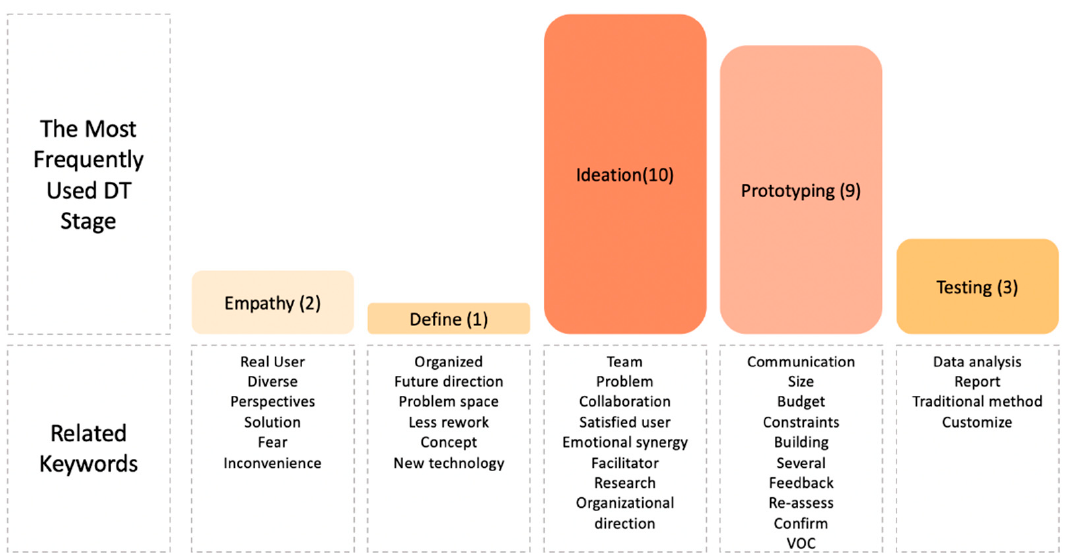
Figure 3. Five-step design thinking model visualization.